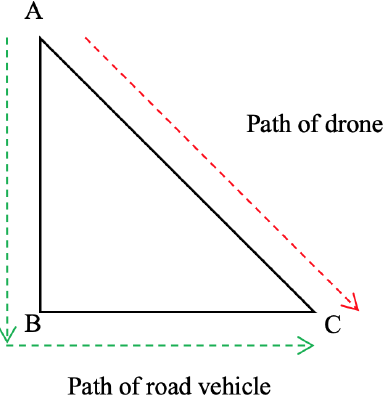
Figure 3. Different travel distance between the drone and road vehicles with the same starting point and ending